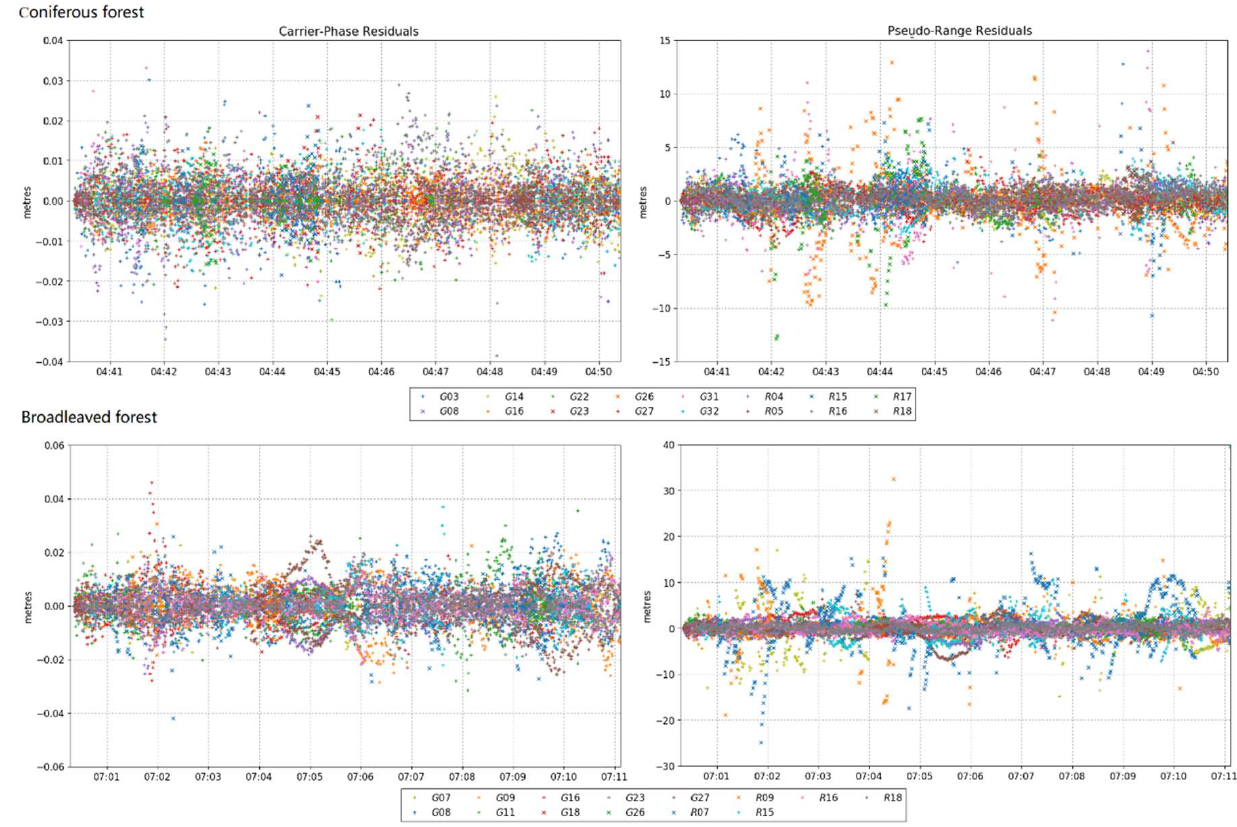
Figure 7. Distributions of carrier phase residuals and pseudo-range residuals with positioning time for single-point positioning in coniferous and broadleaved forests by a GNSS.